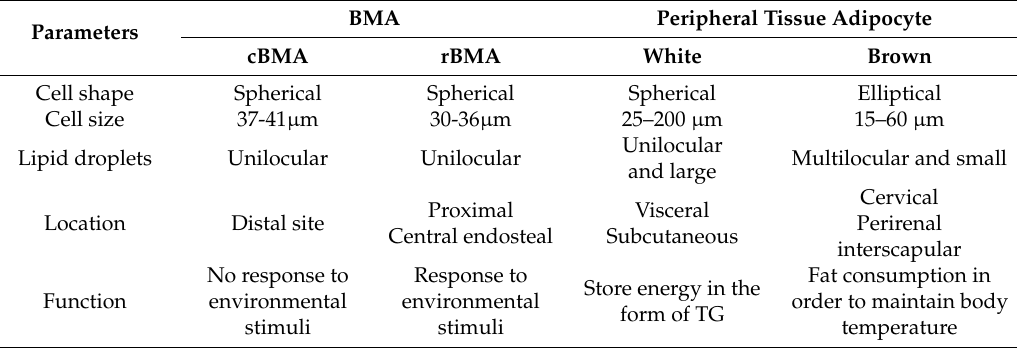
Table 2. Di ff erence between bone marrow adipocytes (BMAs) and peripheral tissue adipocytes.